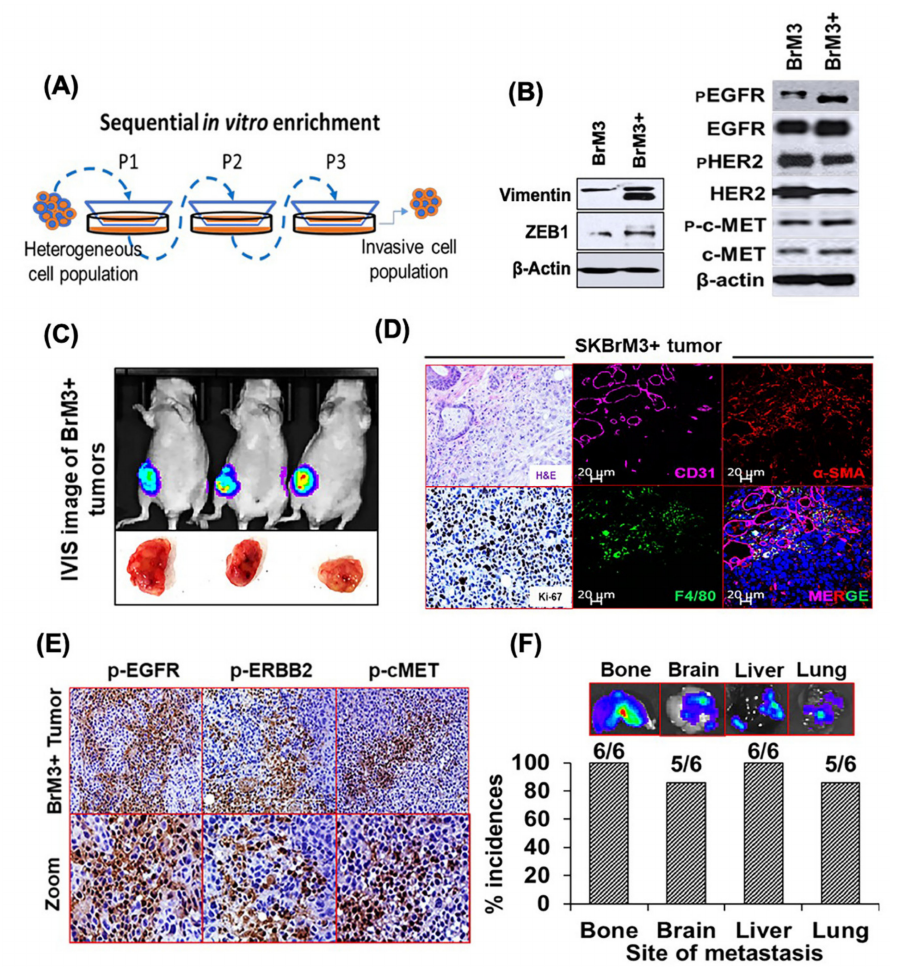
Figure 3. Development and characterization of an orthotopic mouse model for BC. ( A ) Schematic to show in vitro enrichment of migration potential in SKBrM3 cells by sequential passaging through a